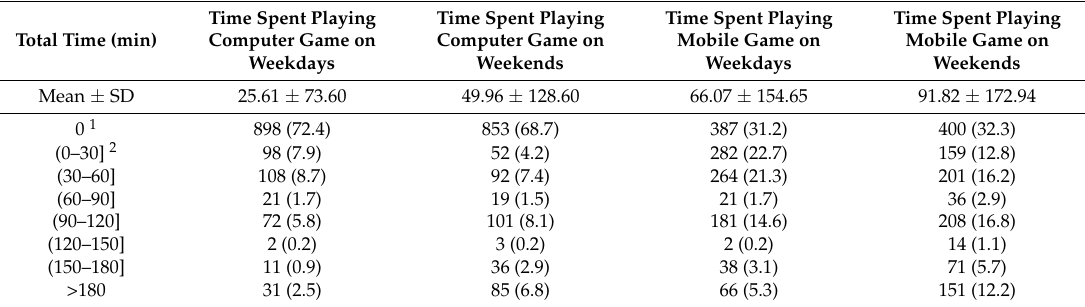
Table 2. Times spent playing games by undergraduate students in Chongqing, China (N, %).